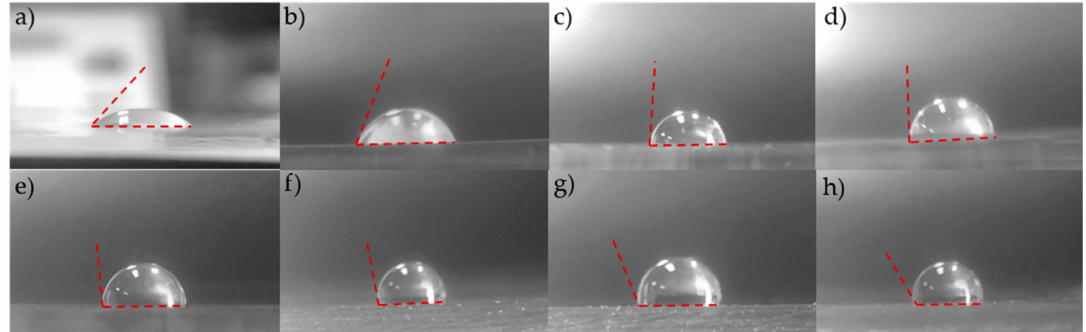
Figure 5. Water drop contact angles on PDMS surfaces treated with different radio frequency (RF) power oxygen plasma before silanization. ( a ) 5 W, ( b ) 10 W, ( c ) 30 W, ( d ) 50 W, ( e ) 80 W, ( f ) 100 W, ( g ) 150 W, ( h ) 200